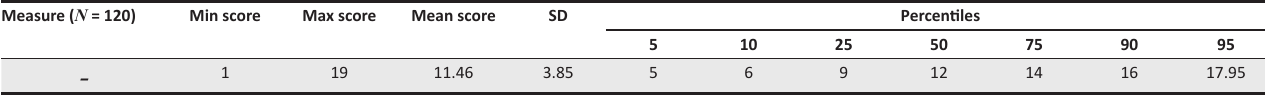
TABLE 1: Descriptive statistics for Northern Sotho non-word repetition task. Measure ( N = 120)